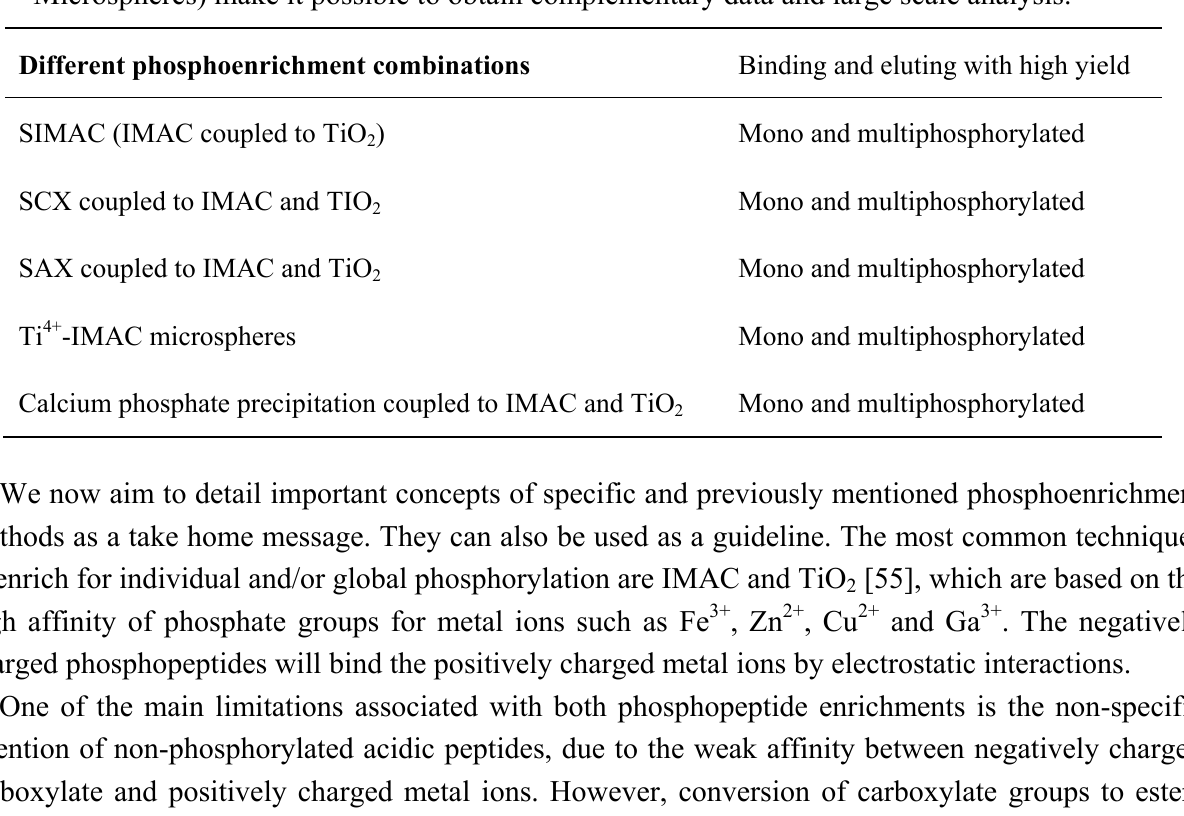
Table 3. Several combinations of phosphoenrichments (e.g., SCX, SIMAC and Ti 4+ -IMAC Microspheres) make it possible to obtain complementary data and large scale